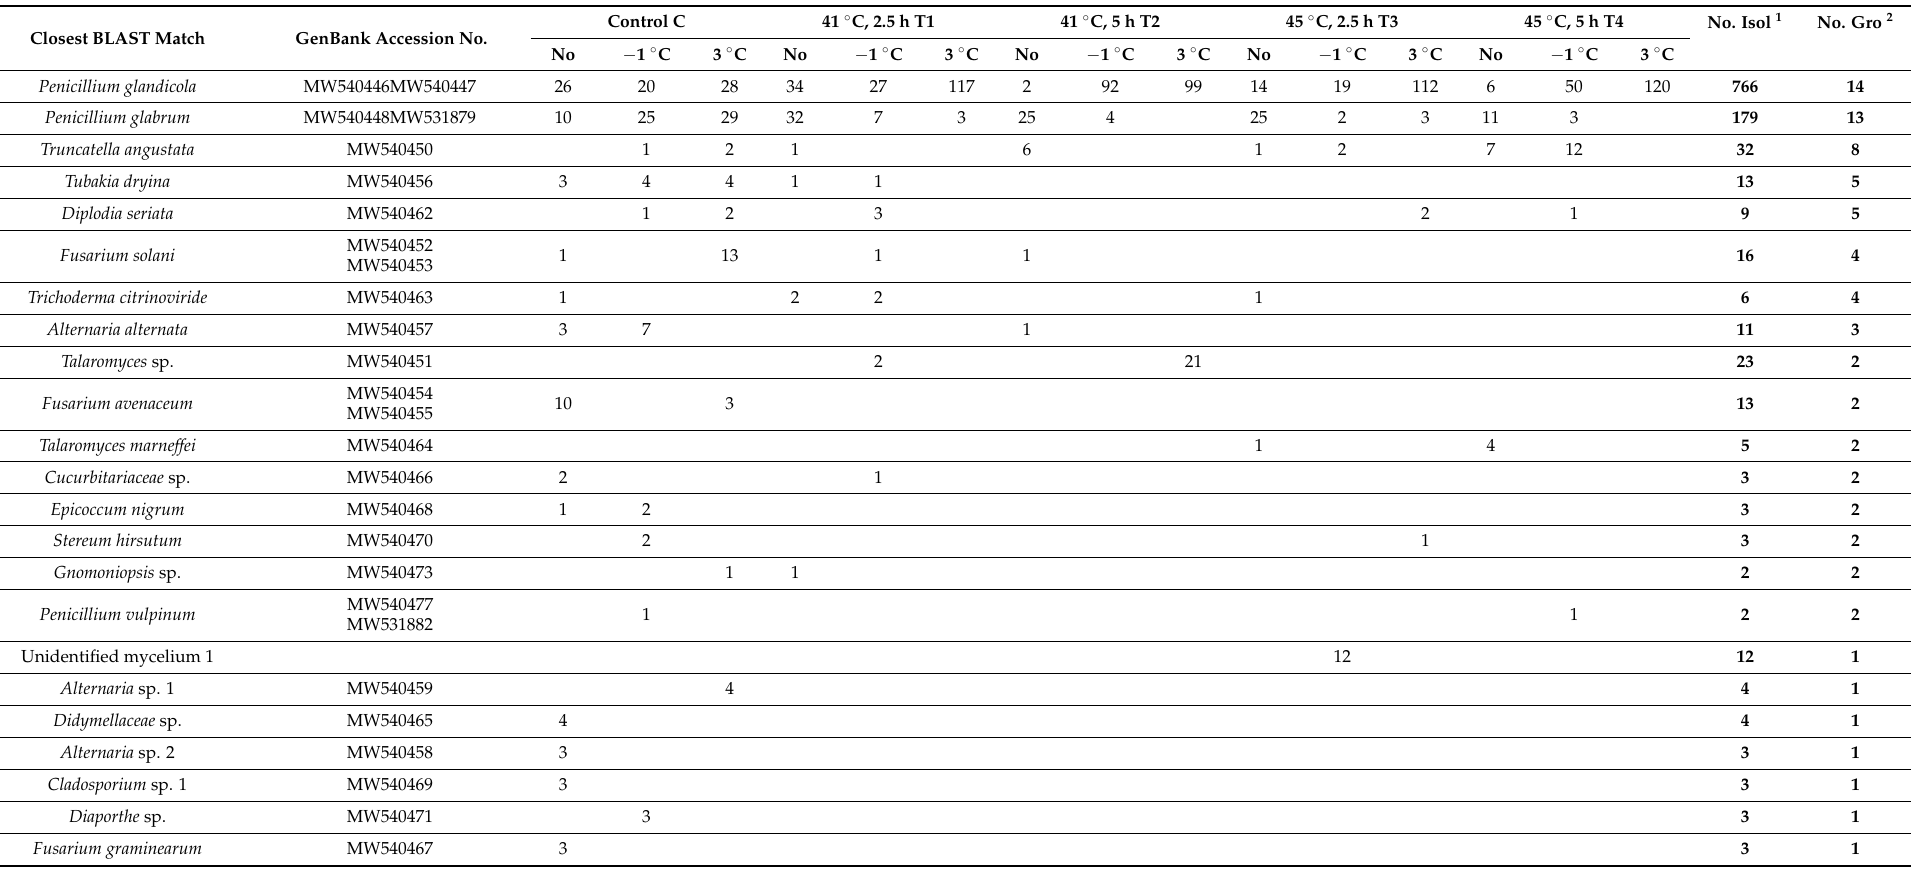
Table A1. Fungal taxa and related number of isolated mycelia from Quercus robur acorns exposed to different thermotherapy (C, T1, T2, T3, and T4) and storage conditions (no storage, at − 1 ◦ C, and at 3 ◦